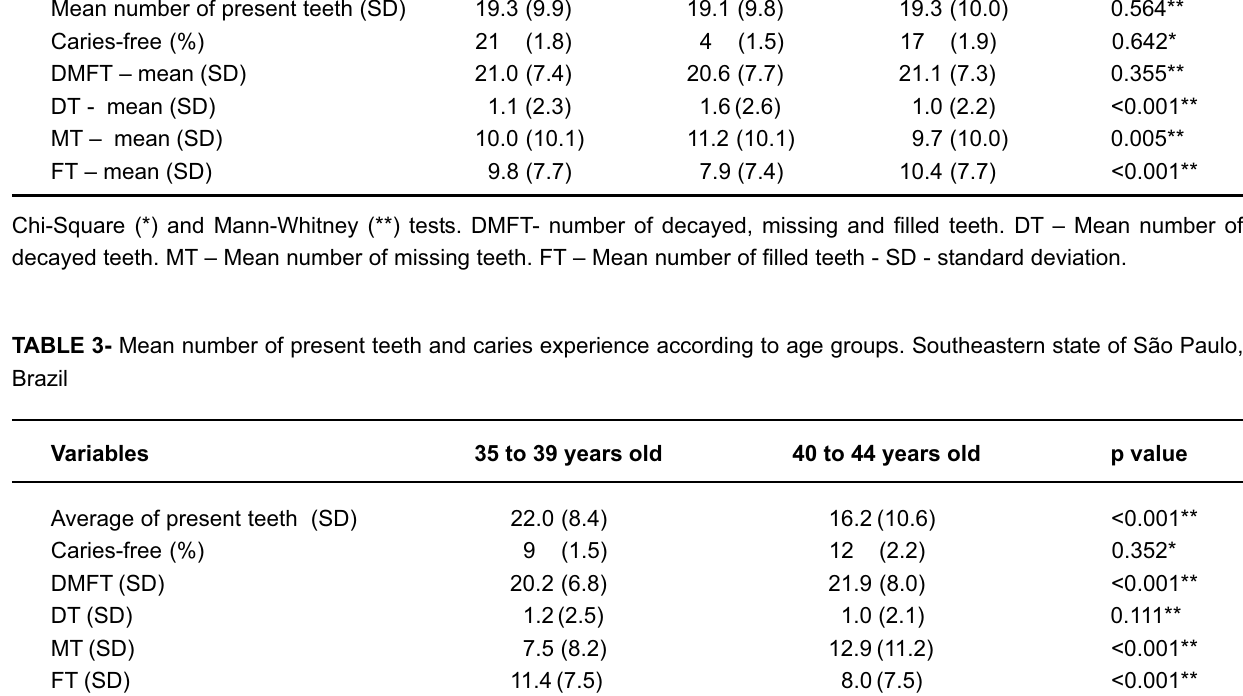
Chi-Square (*) and Mann-Whitney (**) tests. DMFT- number of decayed, missing and filled teeth. DT – Mean number